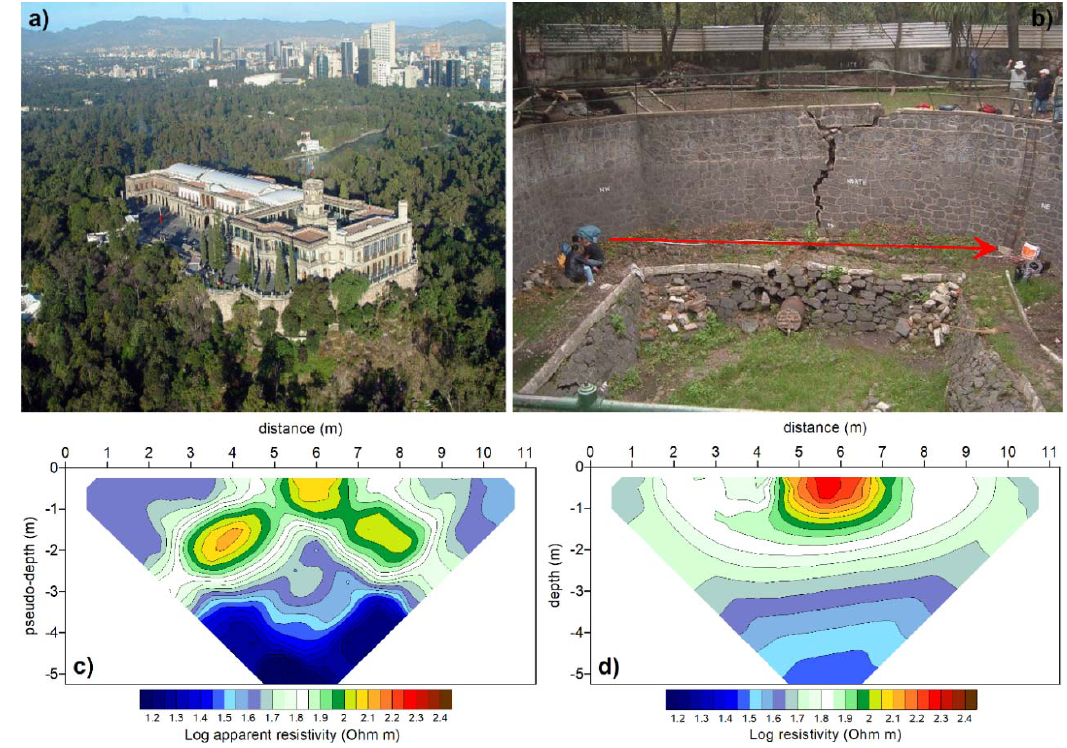
Figure 10. Chapultepec castle on the Chapulín hill in Mexico City ( a ), the Baths of Moctezuma ( b ) with indication of the survey line, the dipole ‐ dipole (DD) pseudosection ( c ) and the PERTI section ( d ).